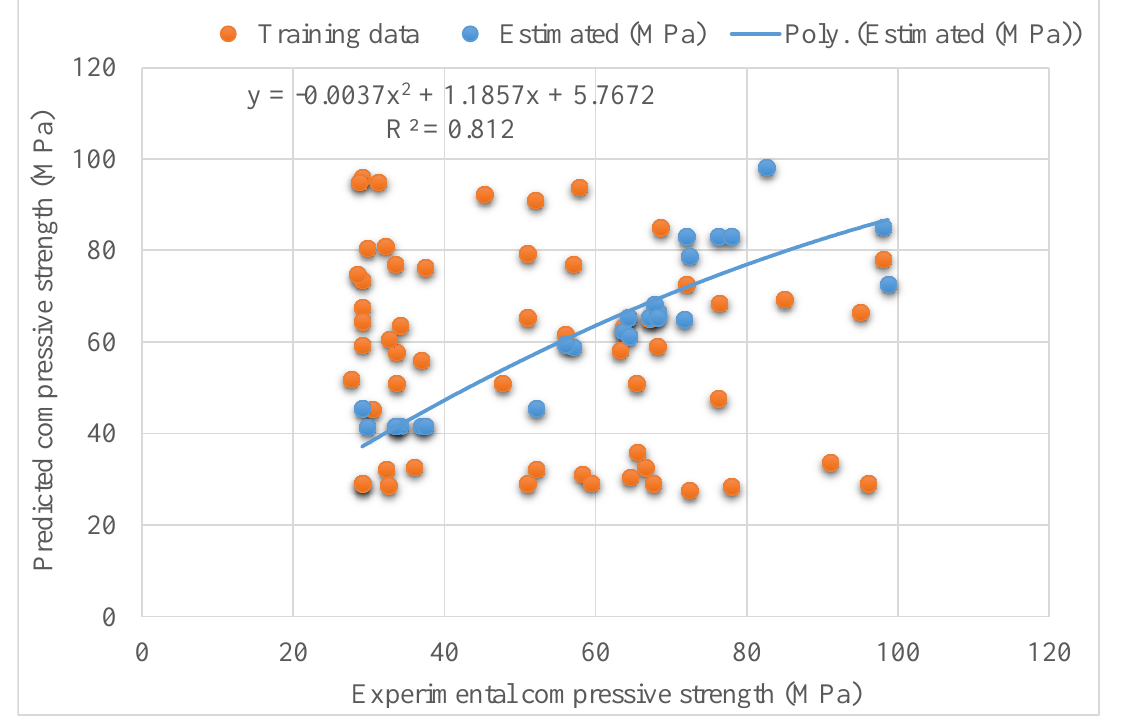
Figure 3. Relationship for support vector regression model: experimental and estimated results.